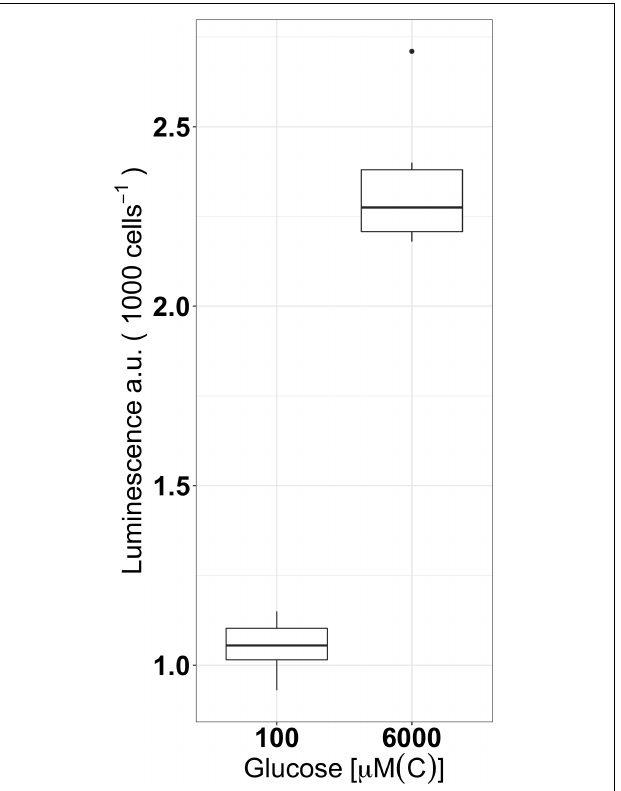
FIGURE 4 | The natural logarithm (ln) of icl -expression measured as luminescence per 1000 cells of icl-luc grown in 6 mM[C] glucose under different levels of Fe-limitation through the addition of DFOB performed in triplicate. Outliers are marked as dots and a.u denotes arbitrary units for